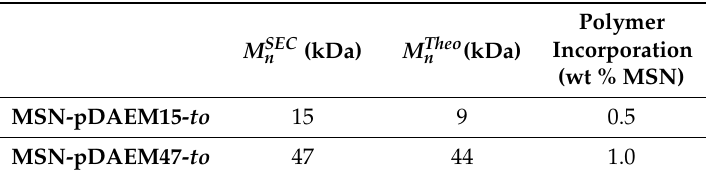
Table 1. Molecular weight of polymers obtained by RAFT (M n values by SEC-MALS) and weight fraction of polymer in the MSN shell incorporated by the grafting- to approach (gRAFT- to